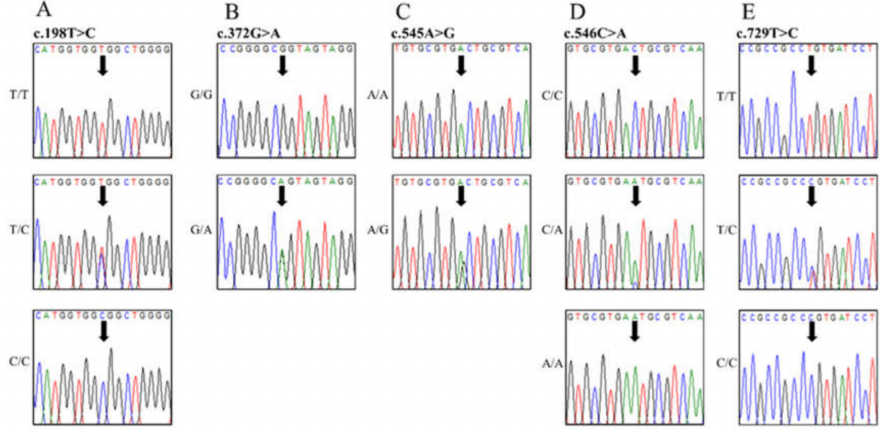
Figure 2. Electropherograms of 5 novel single nucleotide polymorphisms (SNPs) of the canine prion protein ( PRNP ) gene found in dogs. ( A ) Electropherograms showing the three genotypes at polymorphic codon 66 (Gly66Gly). Upper portion GGT / GGT, middle portion: GGT / GGC, and lower portion: GGC / GGC. ( B ) Electropherograms showing the two genotypes at polymorphic codon 124 (Ala124Ala). Upper portion: GCG / GCG and lower portion: GCG / GCA. ( C ) Electropherograms showing the two genotypes at polymorphic codon 182 (Asp182Glu). Upper portion: GAC / GAC and lower portion: GAC / GGC. ( D ) Electropherograms showing the three genotypes at polymorphic codon 182 (Asp182Gly). Upper portion: GAC / GAC, middle portion: GAC / GAA, and lower portion GAA / GAA. ( E ) Electropherograms showing the three genotypes at polymorphic codon 243 (Pro243Pro). Upper portion: CCT / CCT, middle portion: CCT / CCC, and lower portion: CCC /